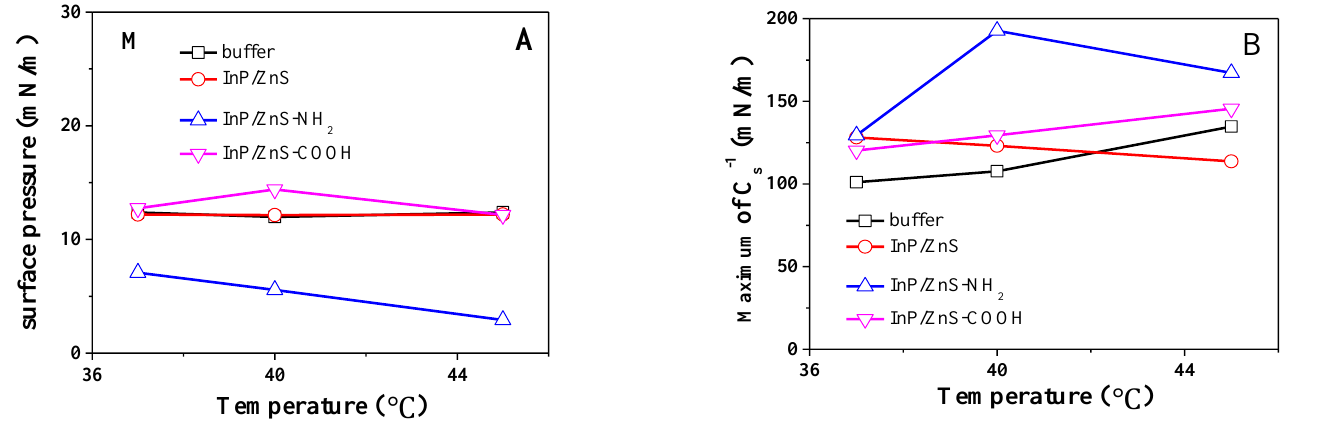
Figure 2. The surface pressure of phase transition point ( A ) and the maximum of 𝐶 𝑠−1 ( B ) for the DPPC/DPPG mixed monolayer at 37 °C, 40 °C and 45 °C.